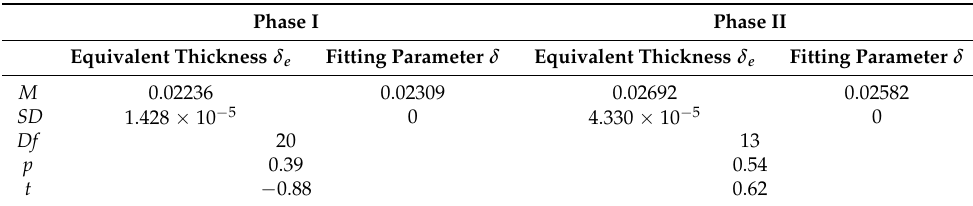
Table 2. Statistical analysis results with a significance level of 0.05. δ e values in numerical simulations were not statistically different from δ in model fitting.